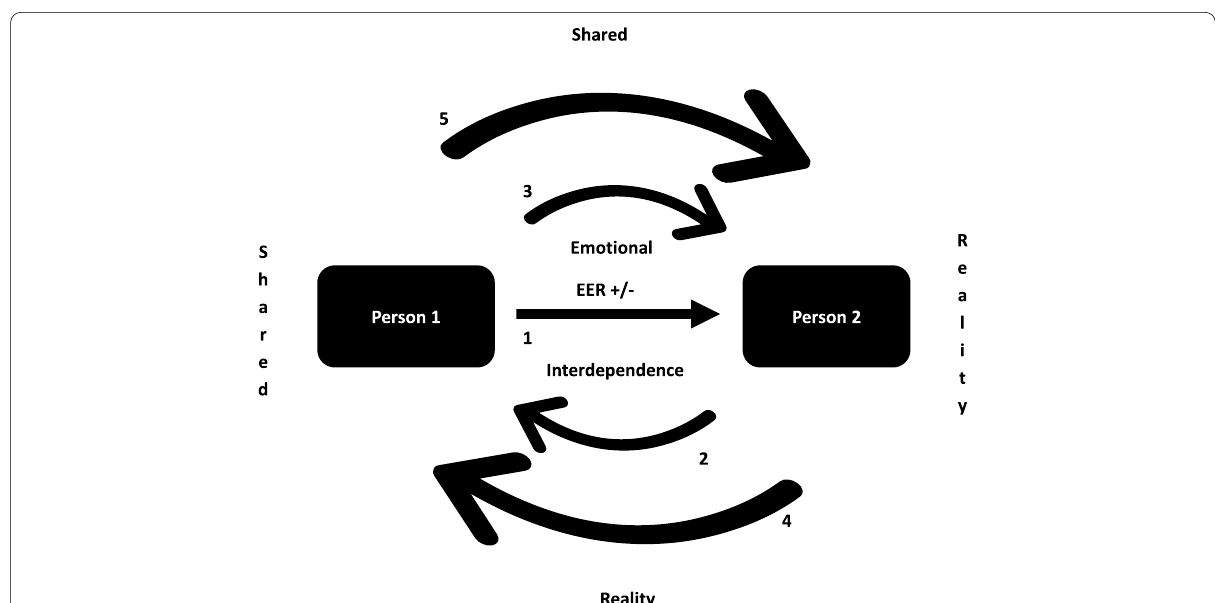
Fig. 1 Emotional interdependence: the key to studying extrinsic emotion regulation in romantic dyads. (1) Positive or negative EER of person 1, generates a positive or negative emotional response in person 2. (2) This response, in turn, generates positive or negative emotions in person 1, along with other associated phenomena. (3) The couple as a circular system, emotions and other related phenomena continue in a reciprocal and iterative loop, which allows the couple at some point to build meanings around their identity as a dyad and the quality of their relationship, between others. (4) Since the effects of the EER occur within the framework of emotional interdependence, the identity of the dyad allows more complex phenomena such as a reality that is mutually shared (5), which in turn will be reinforced according to the successive emotional responses that continue to occur among its